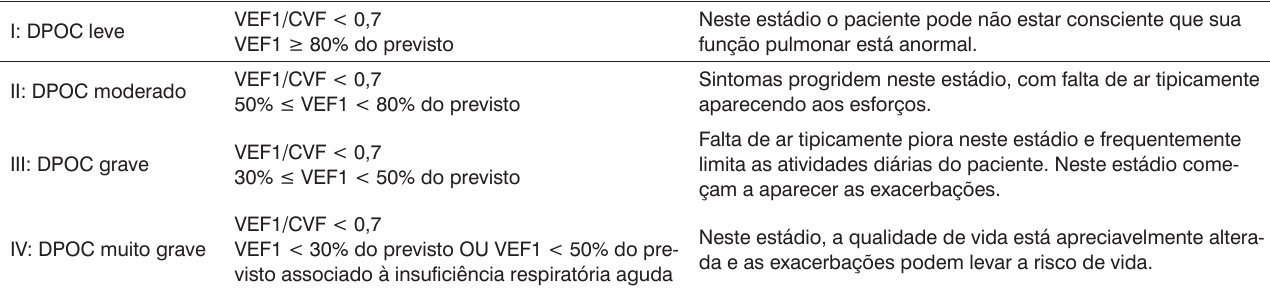
Tabela 1. Critérios espirométricos para gravidade da DPOC conforme